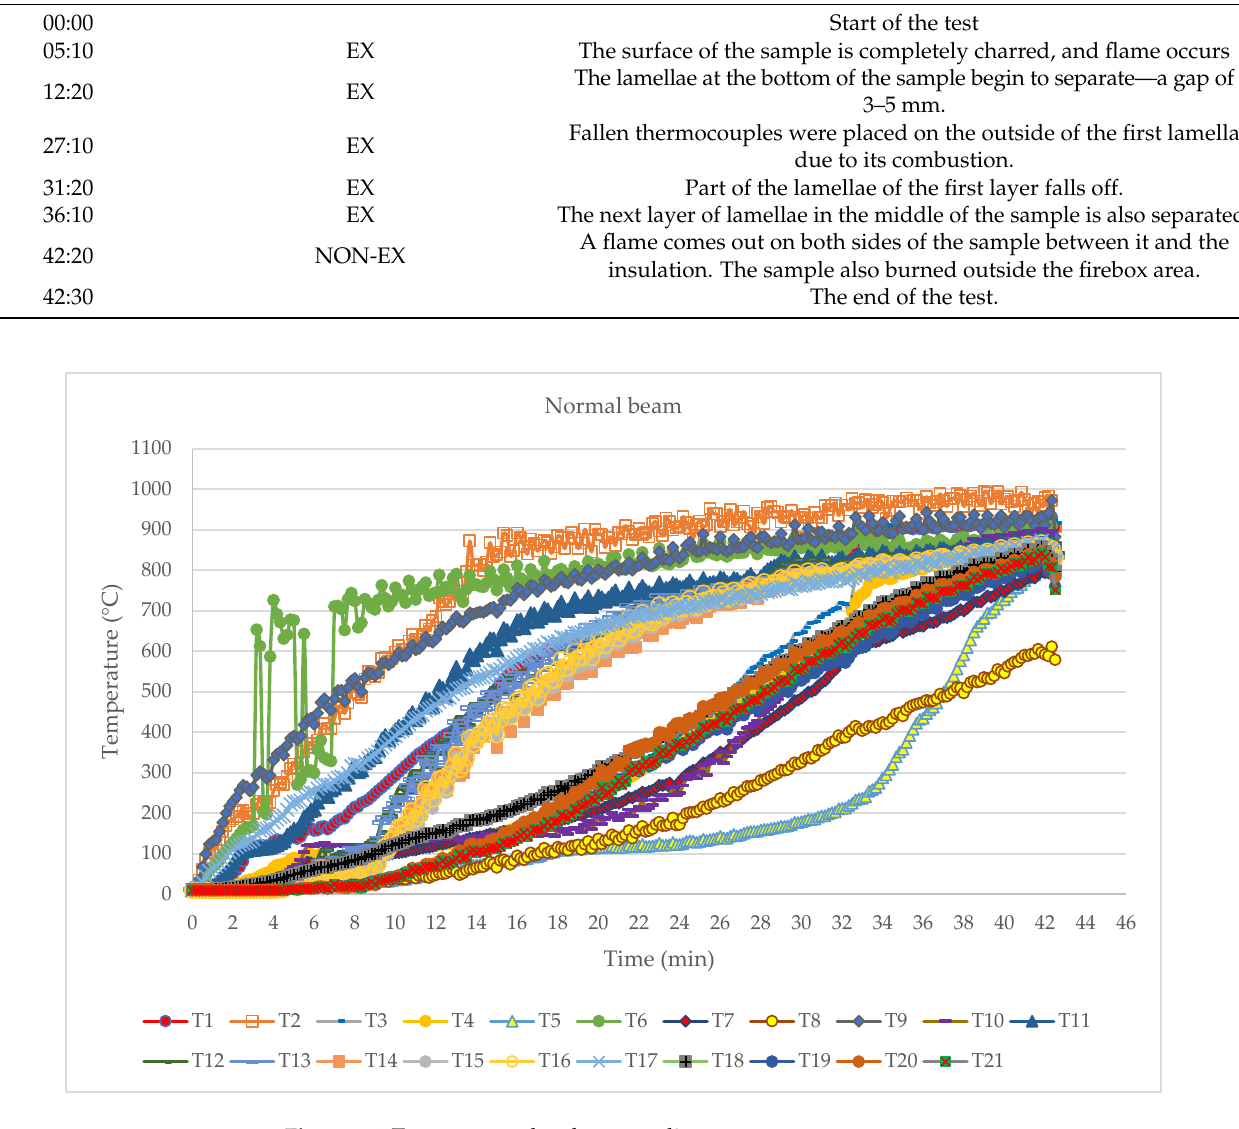
Figure 14. Temperature development diagram.